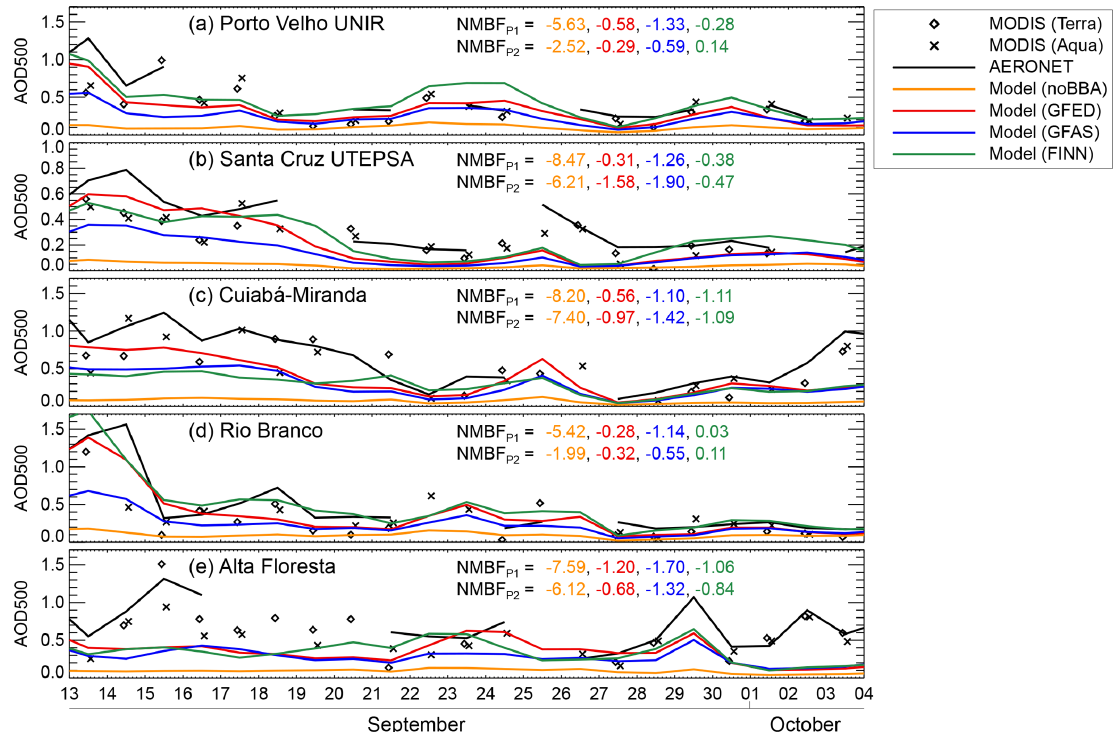
Figure 8. Time series of simulated (colour) and observed (black) daily aerosol optical depth (AOD) during the SAMBBA campaign at five AERONET stations in the western and southern Amazon: (a) Porto Velho UNIR (8.84 ◦ S, 63.94 ◦ W), (b) Santa Cruz UTEPSA (17.77 ◦ S, 63.20 ◦ W), (c) Cuiabá-Miranda (15.73 ◦ S, 56.02 ◦ W), (d) Rio Branco (9.96 ◦ S, 67.87 ◦ W) and (e) Alta Floresta (9.87 ◦ S, 56.10 ◦ W). Daily mean AOD at 500nm (AOD500) from AERONET (black line) is compared to AOD550 retrieved by MODIS (Terra: black diamonds; Aqua: black crosses), using grid cells nearest to the AERONET station location. Simulated daily mean AOD500 is shown for the model with FINN1.5 (green), GFAS1.2 (blue), GFED4 (red) emissions and with no biomass burning emissions (noBBA; orange). The NMBF values are given separately for Phase 1 (P1) and Phase 2 (P2) of the